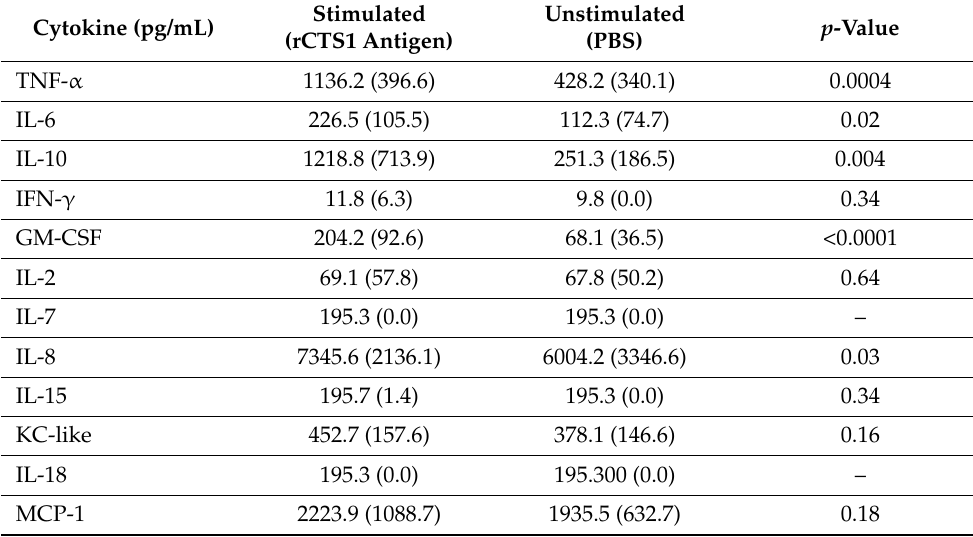
Table 2. Comparison of supernatant cytokine concentrations in 10 healthy controls after exposure to phosphate-buffered solution (negative control) and stimulated with rCTS1 antigen. Data presented as mean and standard deviation.